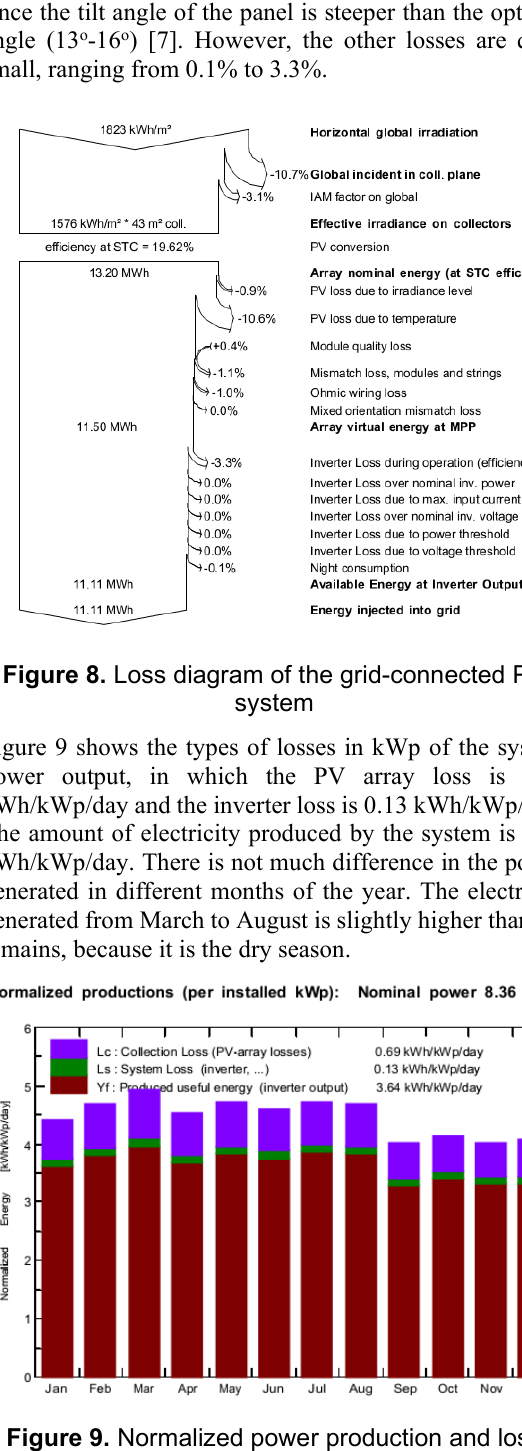
Figure 9. Normalized power production and loss